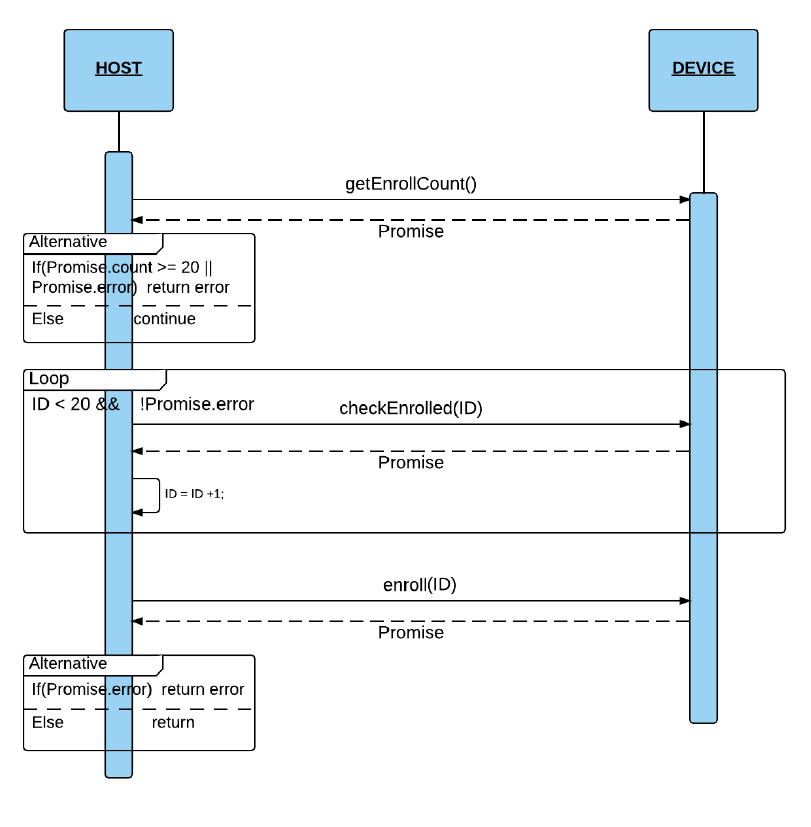
Figure 4. Enroll